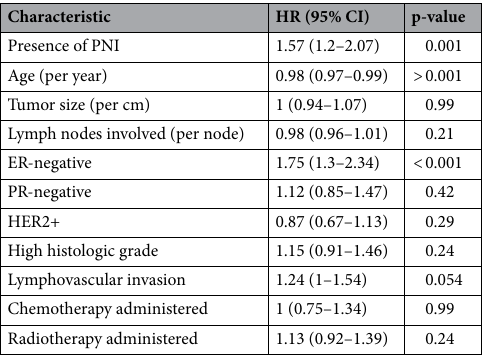
Table 3. Multivariable analysis of locoregional recurrence by clinicopathologic features.